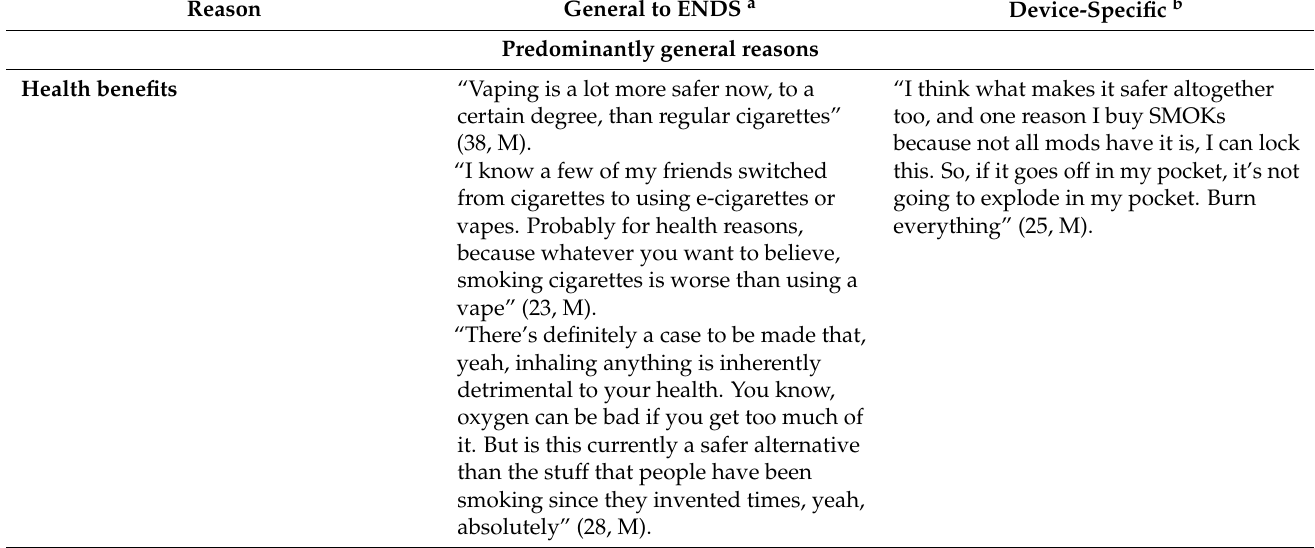
Table 2. Reasons for using ENDS in general and specific